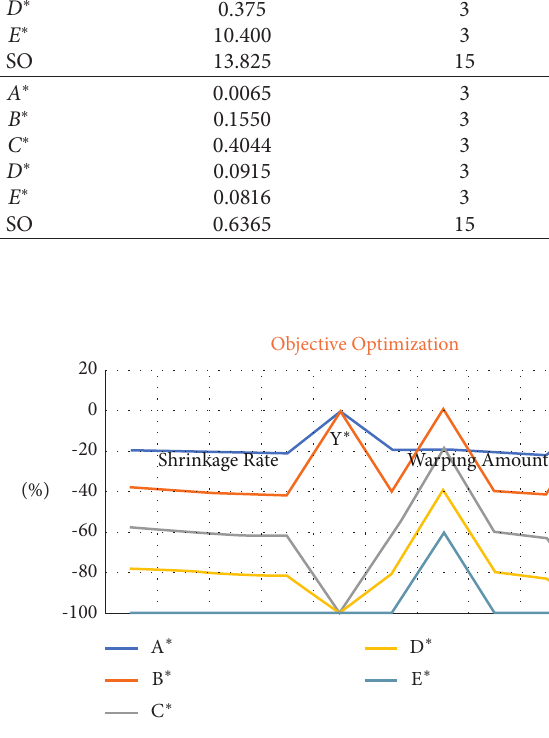
Figure 5: Objective optimization based on mean value.